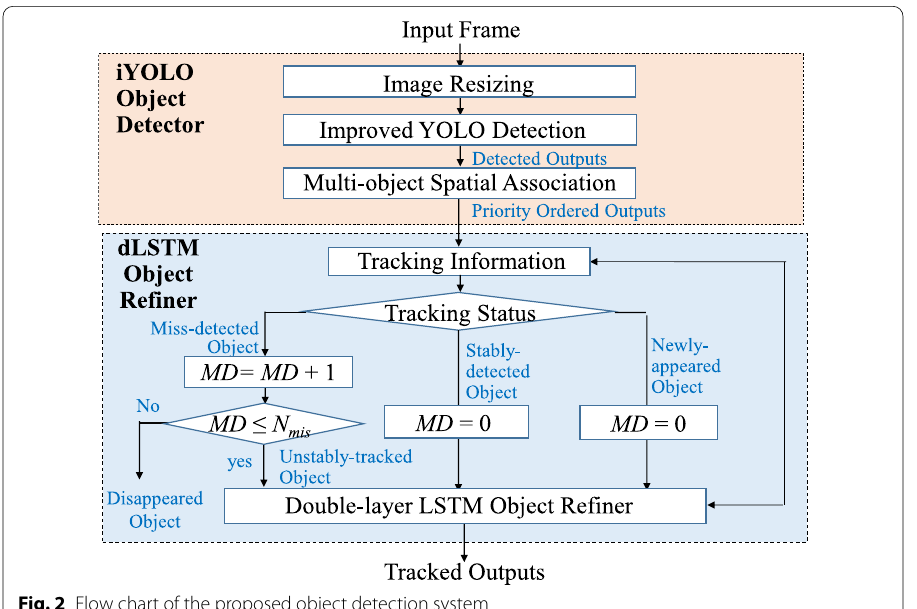
Fig. 2 Flow chart of the proposed object detection